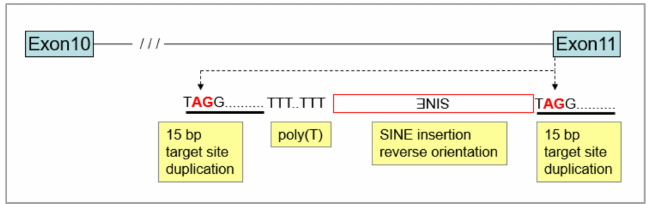
Figure 2. Structure of merle-SINE (short interspersed nuclear element) insertion in the PMEL locus. Insertion occurred at the 5 (cid:48) end of exon 11 in reverse orientation, resulting in target site (red) duplication (15 bp) flanking the merle-SINE element. Sequences are shown as they appear in forward orientation within the PMEL